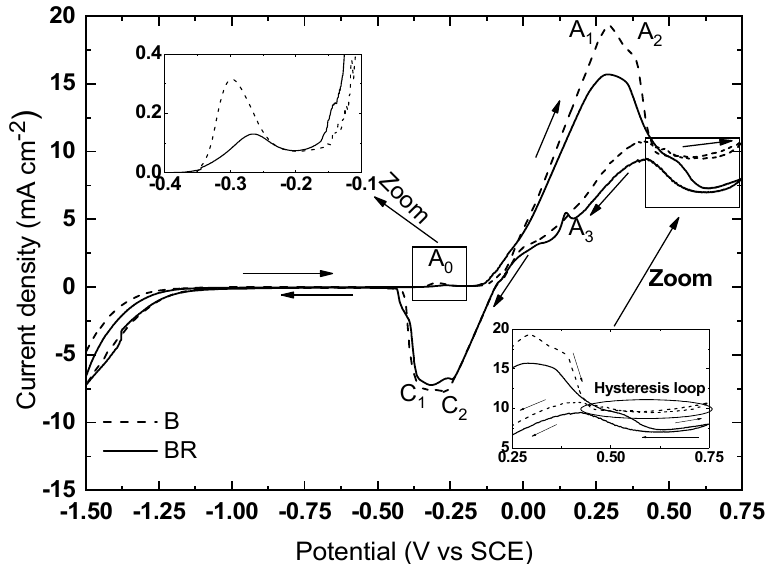
Figure 5. Cyclic voltammogram (from − 1.5 to 0.75 V vs SCE) in 3.5 wt.% NaCl solution at a 1 mV s − 1 scan rate for B (as-cast) and a BR (annealed) samples. 232